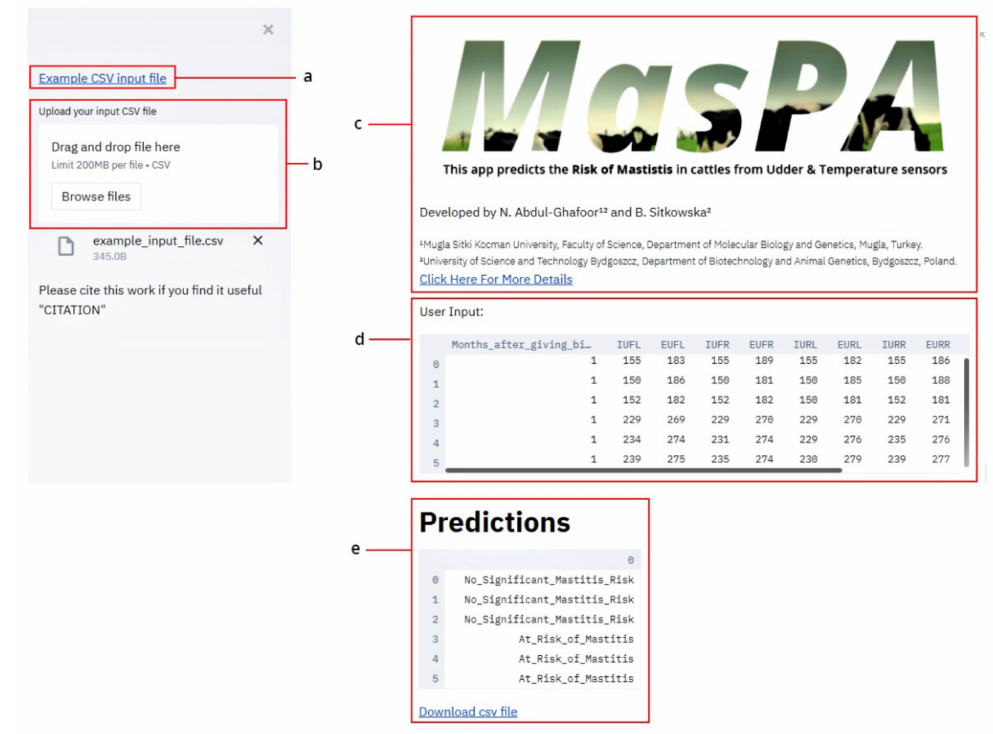
Figure 2. The MasPA interface. ( a ) Link to input example/template, ( b ) options to add input file, ( c ) authors and affiliations, ( d ) preview of the user input, and ( e ) prediction results and link to download the results as a comma separated file